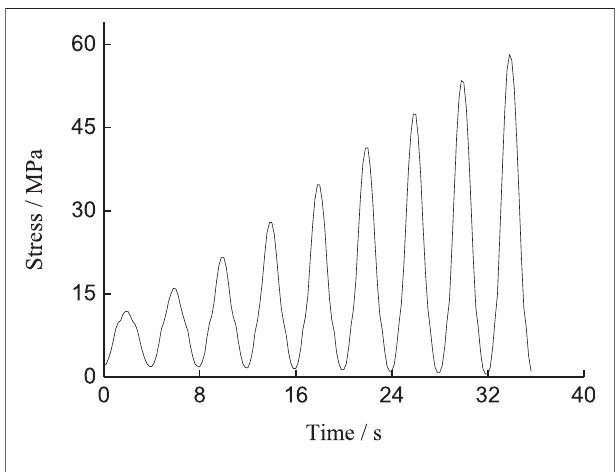
FIGURE 4 | Schematic diagram of cyclic loading.